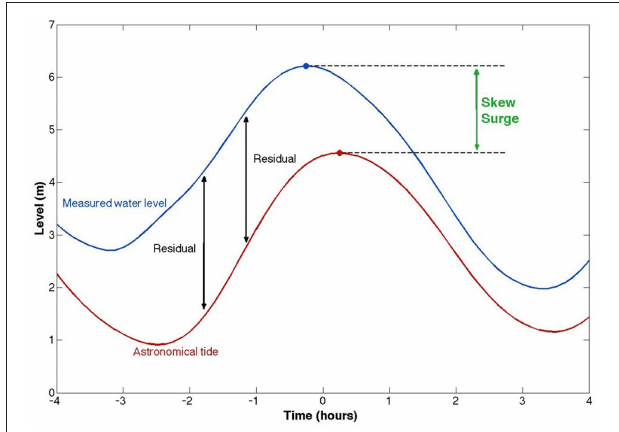
FIGURE 2 | Schematic example of a storm surge event and the different calculation methods for the NTR and skew